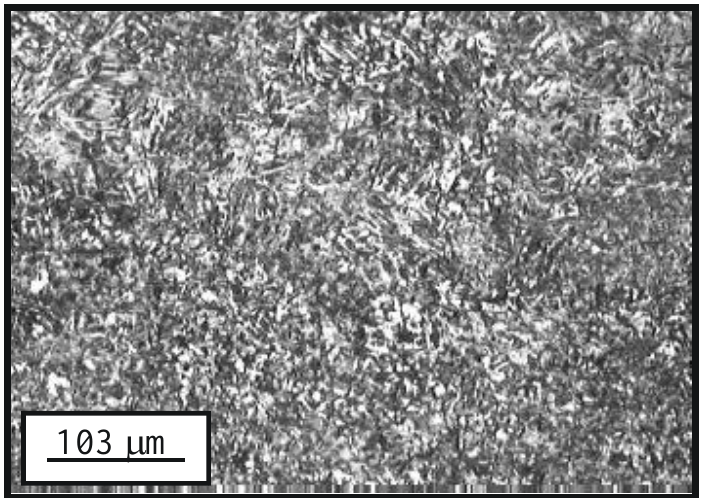
Figure 12. Microstructure of transition between the cemented layer and transient layer in the hard- faced layer executed by the FM EVBCrMo, chemically and heat treated.